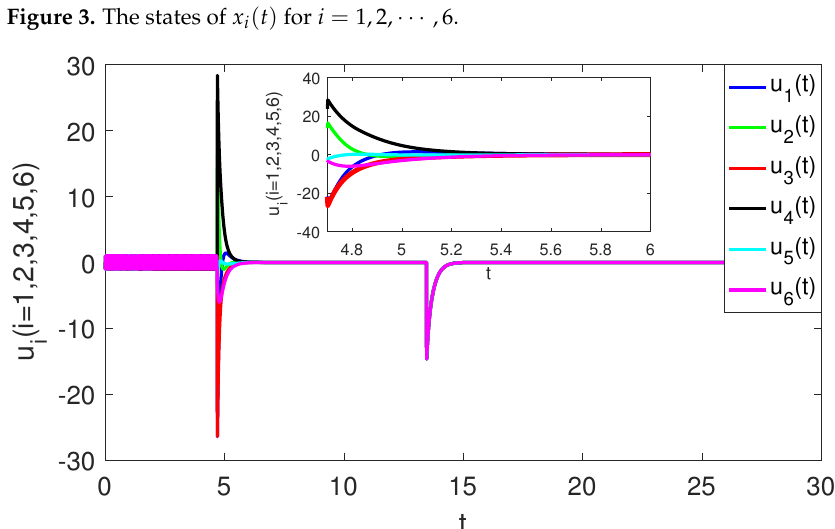
Figure 3. The states of x i ( t ) for i = 1,2, · · · ,6.